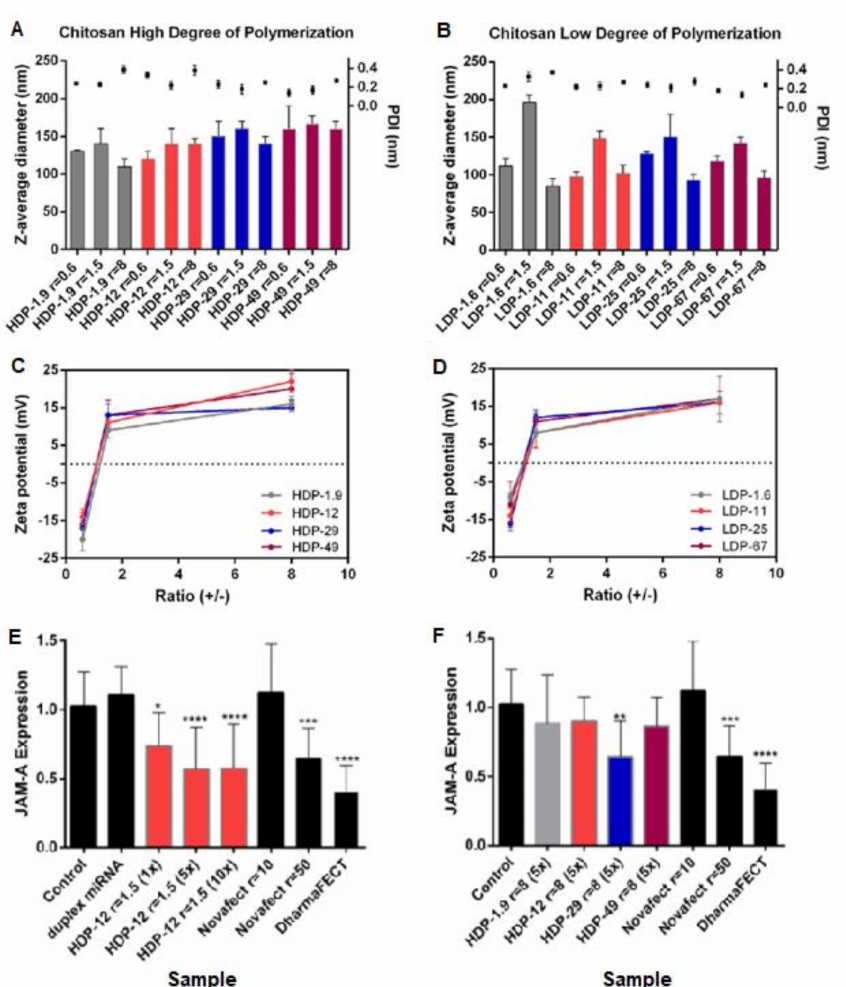
Figure 6. CS-miRNA polyplexes after 30 min incubation at 37o degrees. Z-average diameter in nm, polydispersity index PDI, and zeta potential ZP in samples formulated using ( A , C ) higher molar mass CS and ( B , D ) lower molar mass CS, with their respective transfection efficiency expressed as downregulation of JAM-A mRNA in MCF-7 cells: ( E ) complexes containing high molar mass CS with DA 12% (HDP-12) at (N/P) charge ratio = 1.5; and ( F ) complexes containing CS HDP-1.9, HDP-12, HDP-29, and HDP-49 at (N/P) charge ratio = 8. With HDP-DA%: Higher degree of polymerization/molar mass - degree of acetylation percent. DharmaFECT (5 µ L/well) and Novafect O 25 were used as positive controls and no treatment was used as a negative control. Statistical comparisons were between each treatment and the control of untreated cells using non-parametric Kruskal–Wallis test (* p < 0.1; ** p < 0.01; *** p < 0.001; **** p < 0.0001), licensed under a